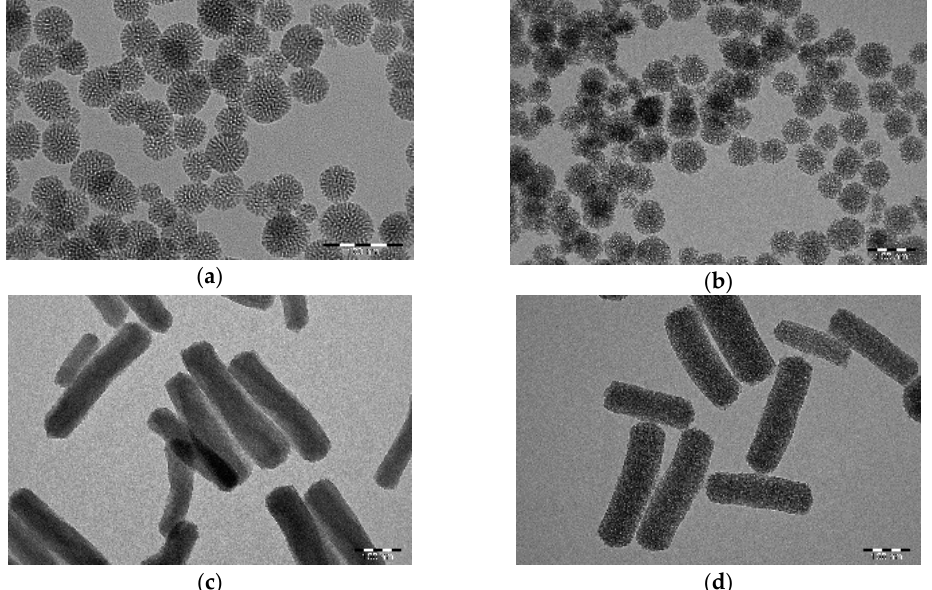
Figure 1. TEM images of ( a ) S-MSN ( b ) S-MSN@PDA ( c ) Rod-MSN ( d ) Rod-MSN@PDA. Scale bar = 100 nm for all images.